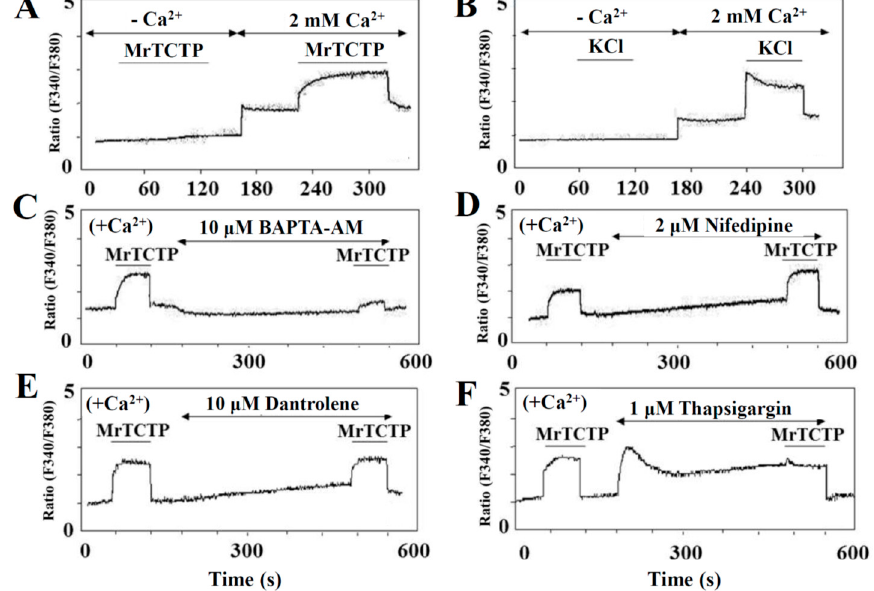
Figure 3. TCTP increases intracellular Ca 2+ concentration. PC12 cells were loaded with 5